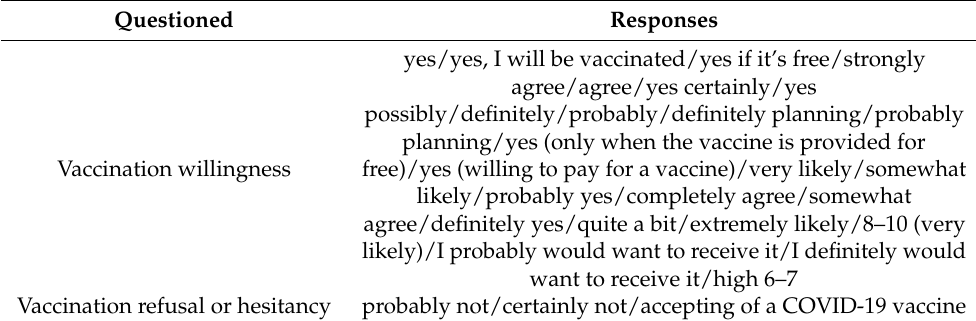
Table 2. Survey question responses categorized as